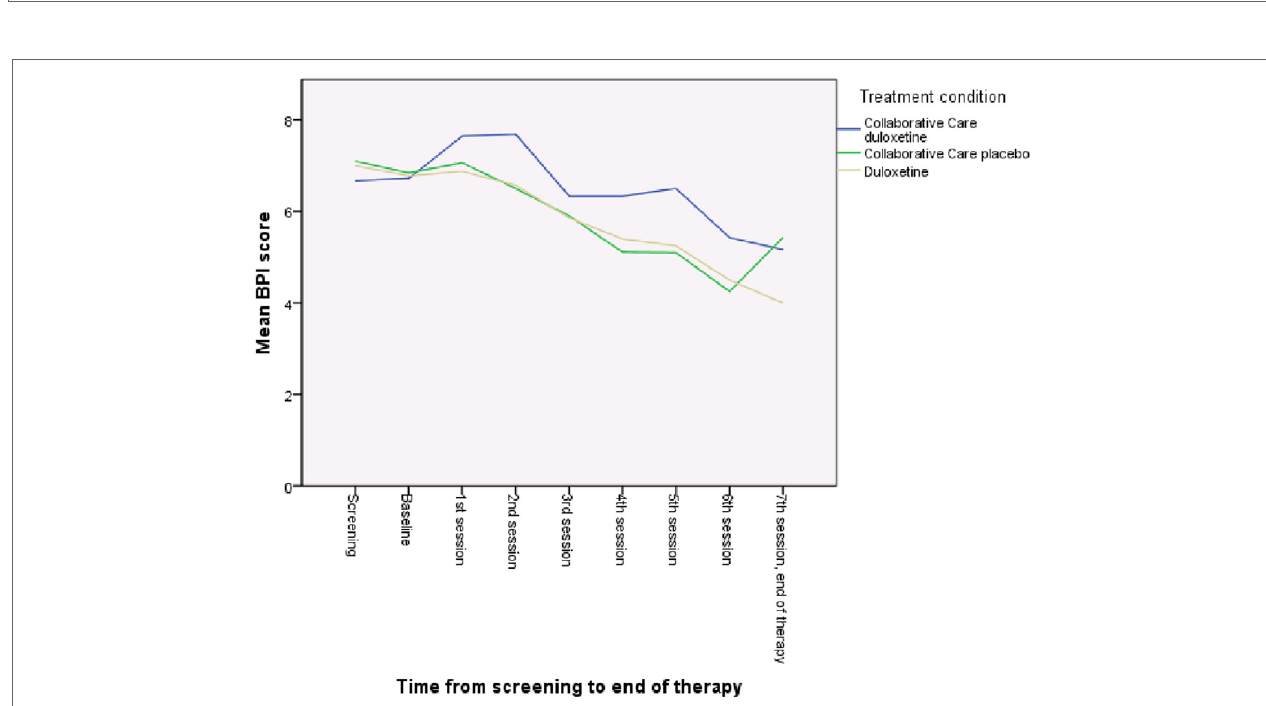
FigUrE 4 | Mean brief pain inventory (BPI) score of the three treatment groups over